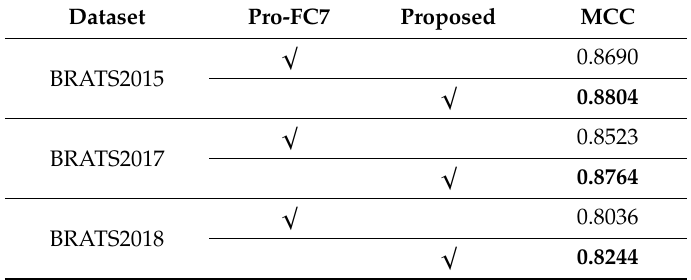
The better values are shown in